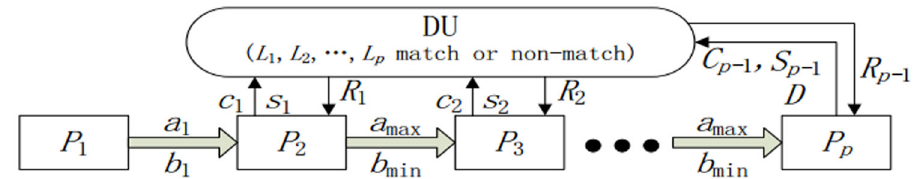
Fig. 2 Process of generating candidate blocks among multiple